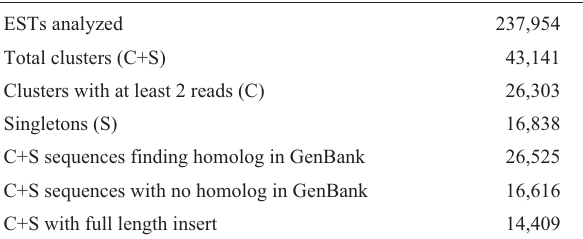
Table V - Statistics of EST clustering and